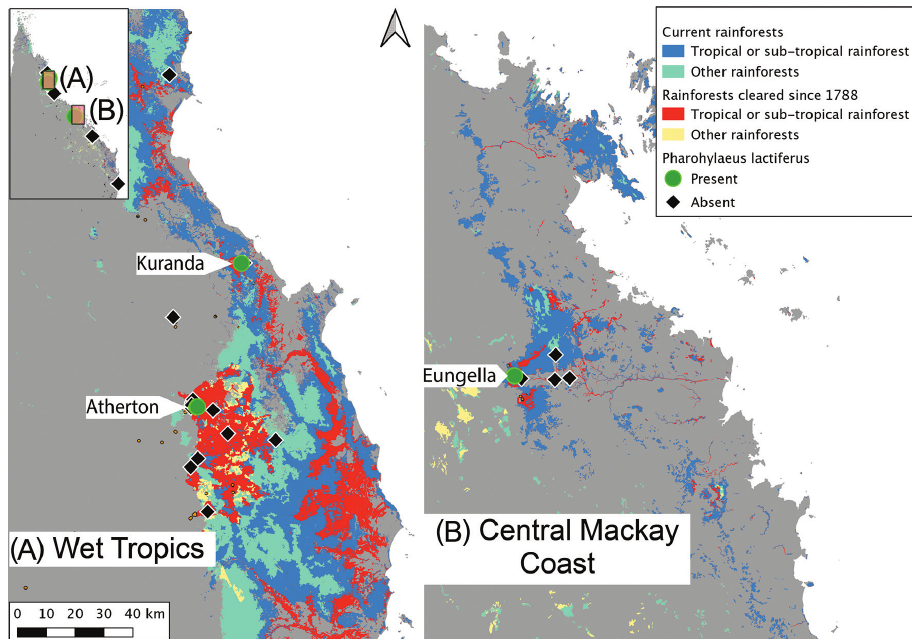
Figure 1. (blues) Current rainforests and (reds) rainforests cleared since European arrival (1788) in the A Wet Tropics and the B Central Mackay Coast (NMD 2003b, a). Black markers indicate flowering Stenocarpus sinuatus or Brachychiton acerifolius , sites where no Pharohylaeus lactiferus were detected, and green markers (Kuranda, Hallorans Hill C.P. (Atherton), and Eungella) indicate those where they were present. Inset shows Queensland and northern New South Wales as well as sample